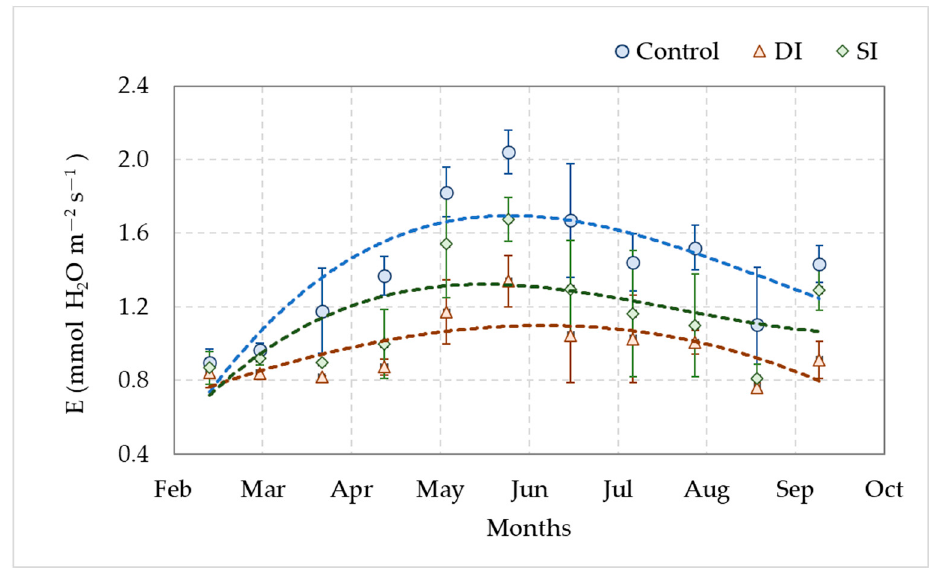
Figure 10. Effect of drip irrigation (DI), subsurface irrigation (SI), and bubbler irrigation (control) systems on transpiration rate (E) of date palm (Khalas cv.). Each data point for SI and DI systems represents an average of 50, 75, and 100% ETc levels, whereas it is at 100% ETc level for control during 2020–2021.